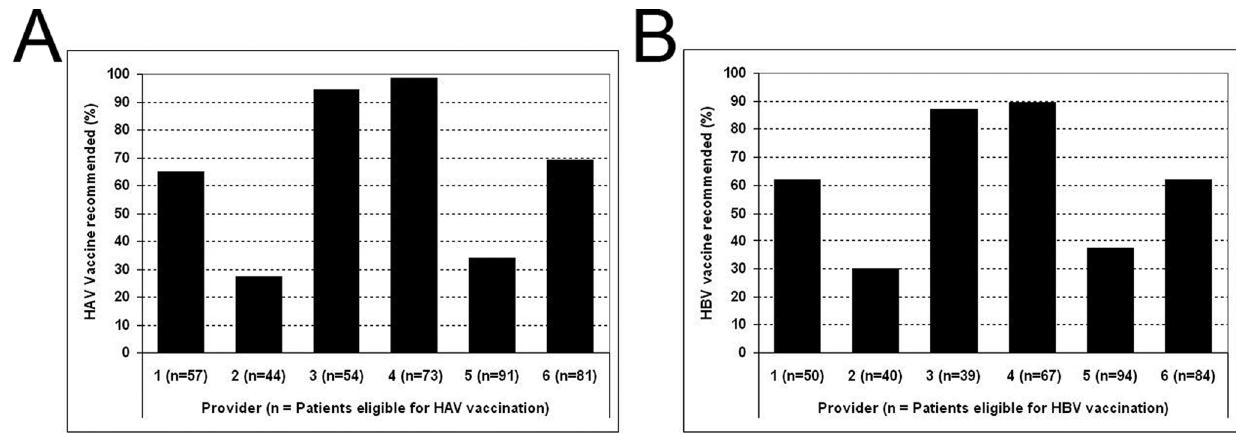
Figure 2. Recommendation for vaccination in eligible patients stratified by liver clinic providers for A) Hepatitis A and B) Hepatitis B.